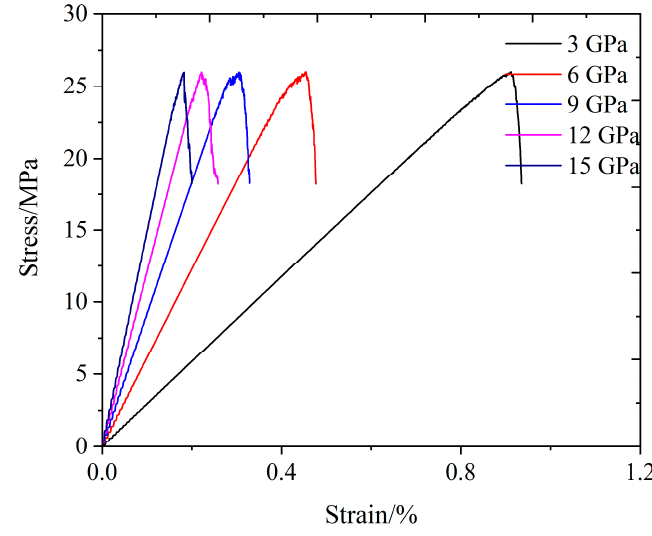
Figure 23. Stress − strain curves with respect to elastic modulus.